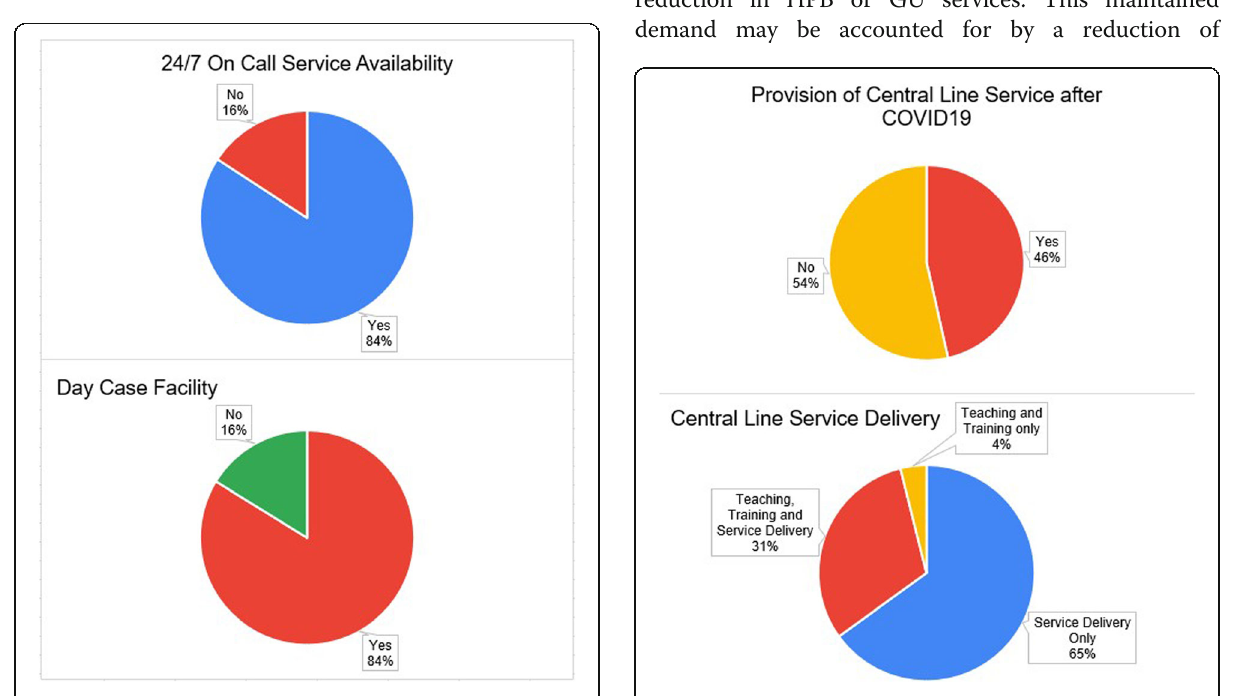
Fig. 3 Availability of on call service and day case facility Fig. 4 Provisions of central line service in response to